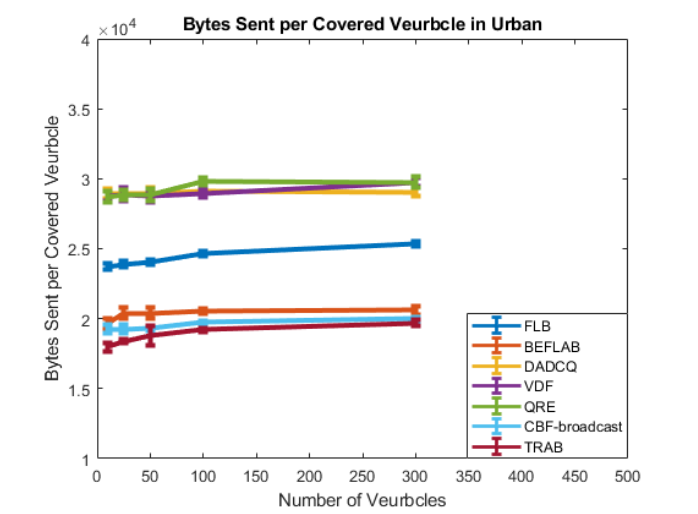
Figure 16. Urban bytes sent per covered vehicle.